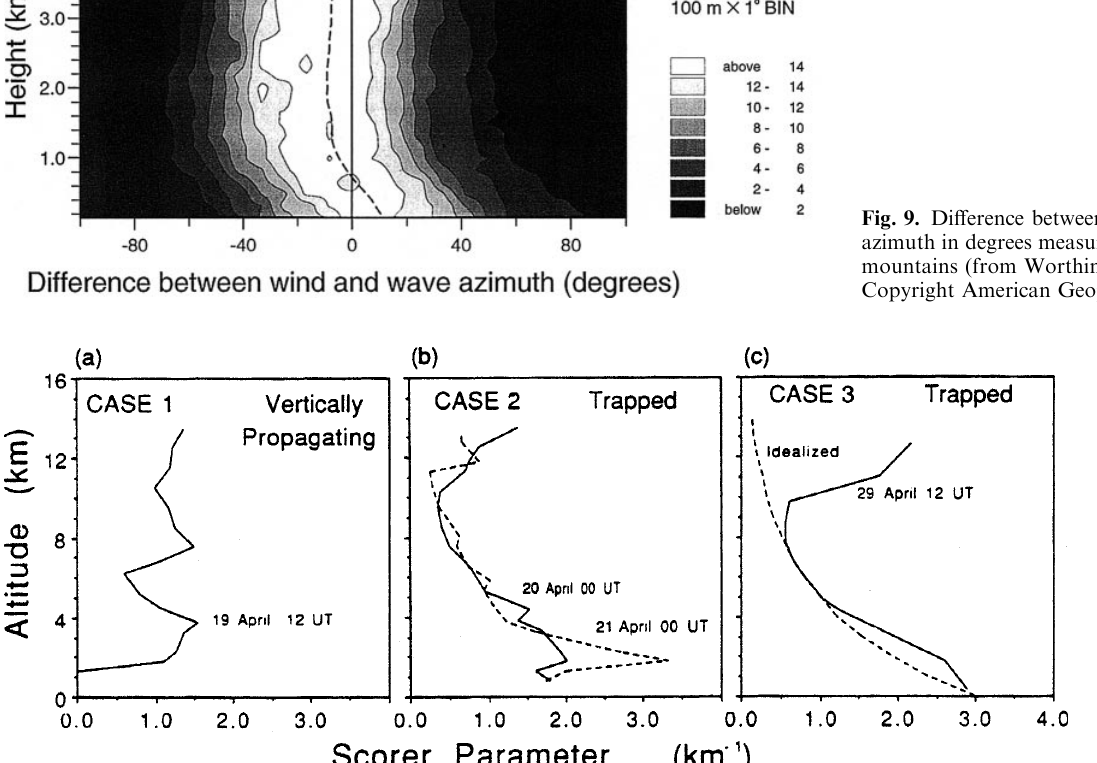
Fig. 10a–c. Vertical profiles of the Scorer parameter calculated from 3–6 h averaged profiles of VHF radar wind and radiosonde temperature (from Ralph et al ., 1992, Copyright Royal Met.